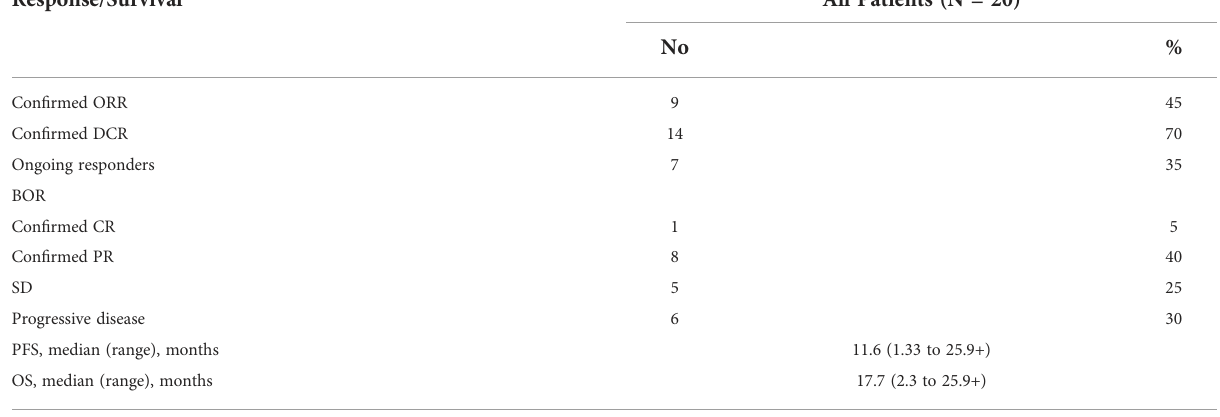
TABLE 2 Summary of response for patients with an intention-to-treat analysis for PFS and OS. Response/Survival